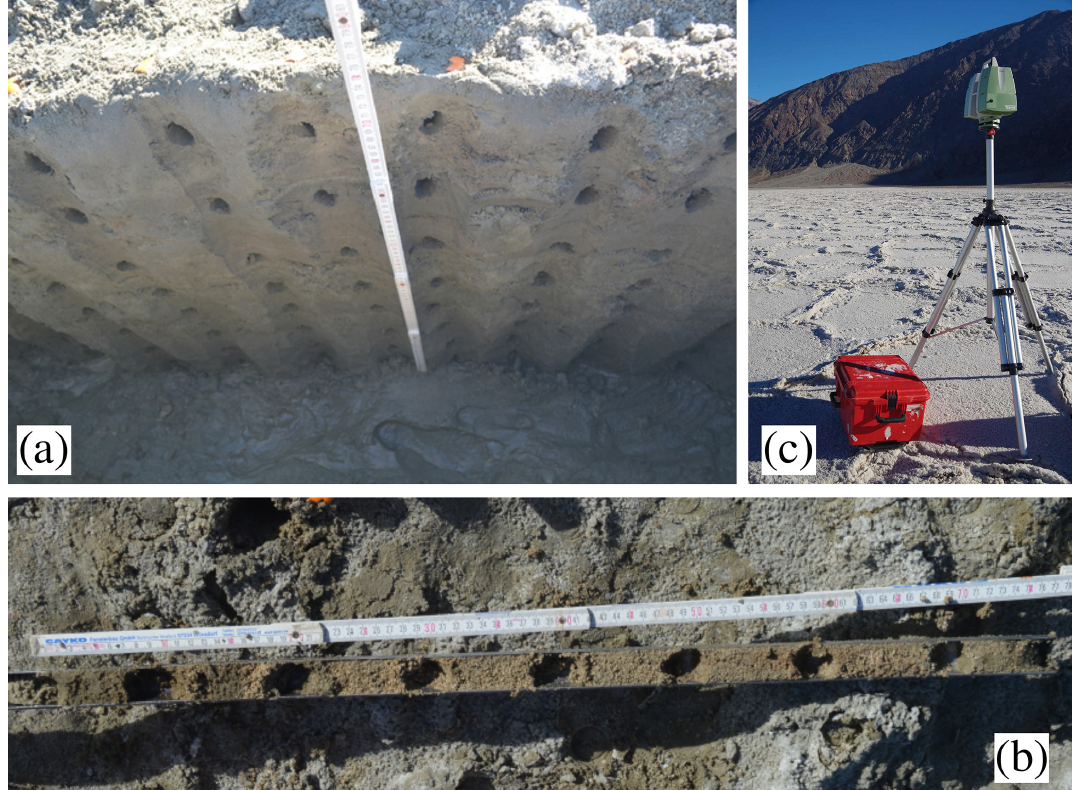
Figure 4. Field methods. (a) Representative trench and sampling positions (holes) at a site at Owens Lake. (b) Dutch gouge auger and sampling positions (holes) at a site at Owens Lake (crust–soil interface is positioned at 0cm). (c) Terrestrial laser scanner (TLS) set-up at Badwater Basin.